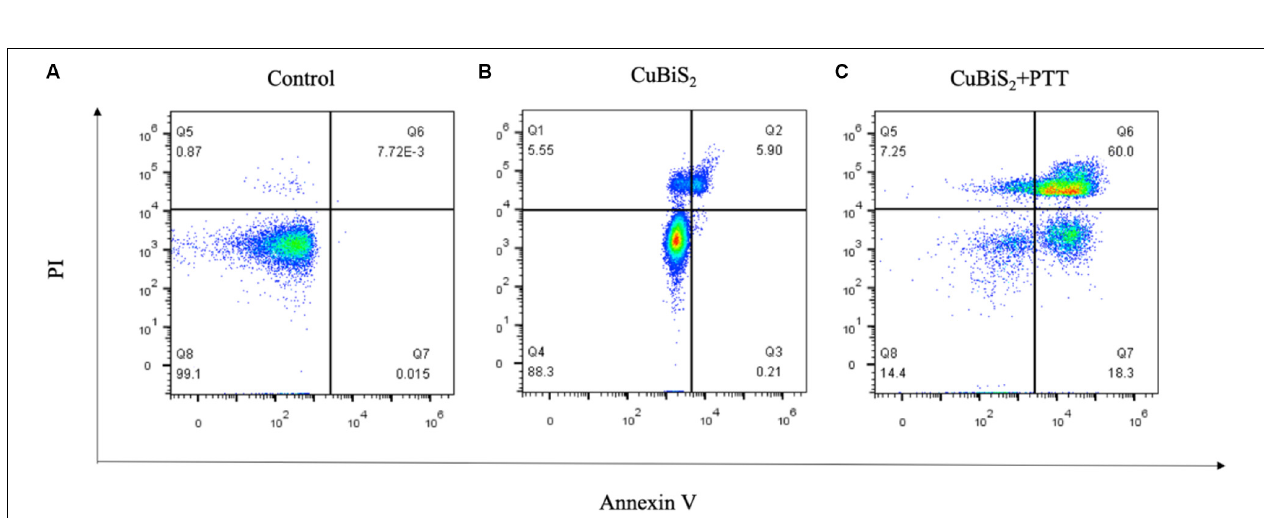
Frontiers in Bioengineering and Biotechnology | www.frontiersin.org